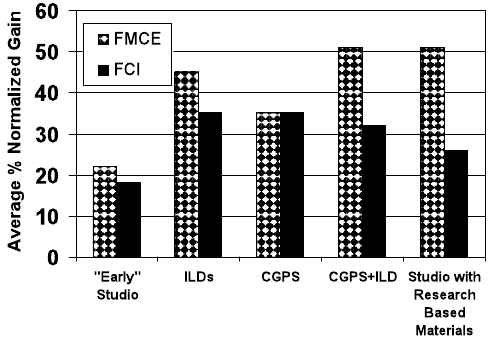
FIG. 4. FMCE and FCI normalized gains for groups of students having had various instructional experiences within the studio phys- ics environment at Rensselaer. N =182 students for the “early stu- dio” group, N =101 for the Interactive Lecture Demonstration group, N =32 for the cooperative group problem solving group, N =30 for the ILD+CGPS group and N =450 for studio with research-